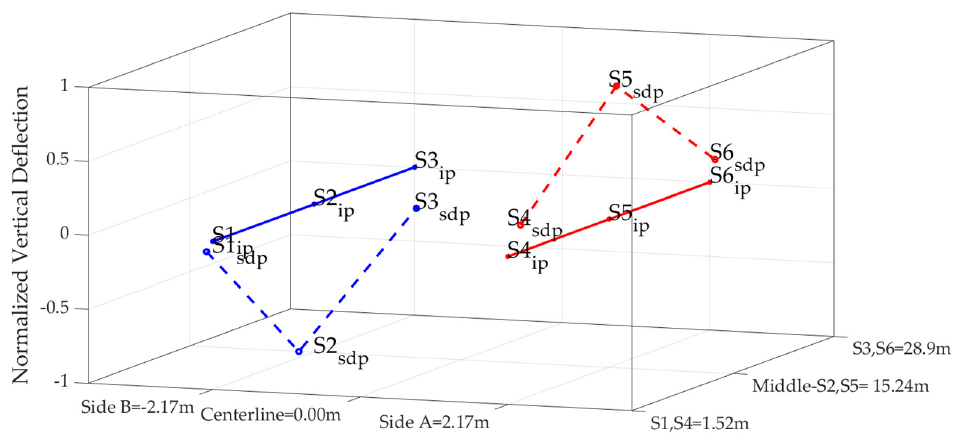
Figure 18. 2nd Identified mode shape—torsional with sensor 4 as reference at 3.42 Hz.